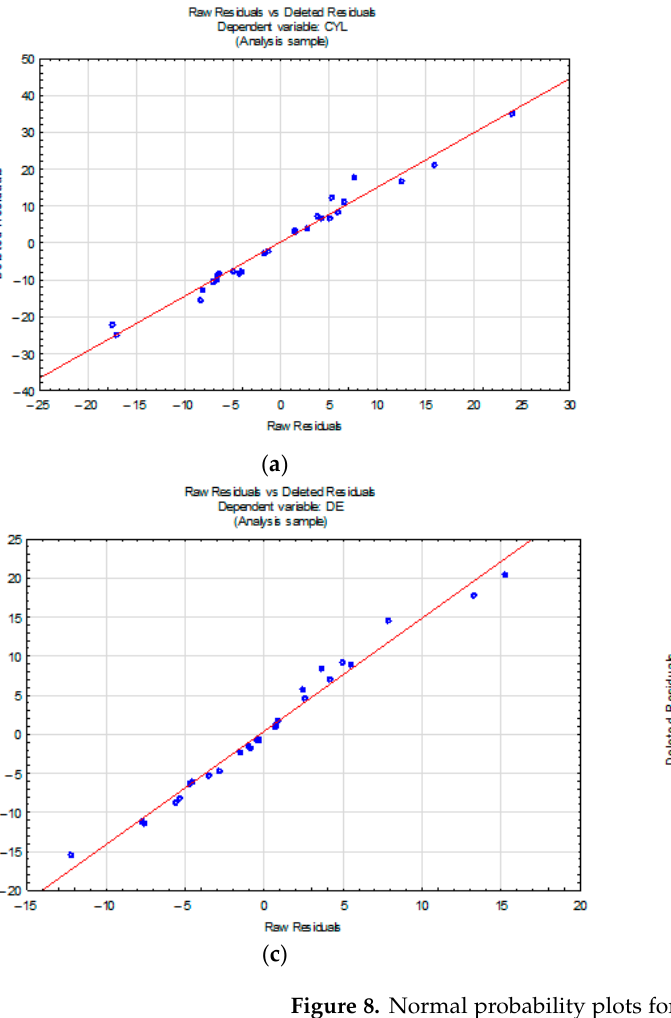
Figure 7. Experimental versus predicted data: ( a ) the cylindricity error; ( b ) the straightness error; ( c ) the diameter error; and ( d ) the parameter R a .